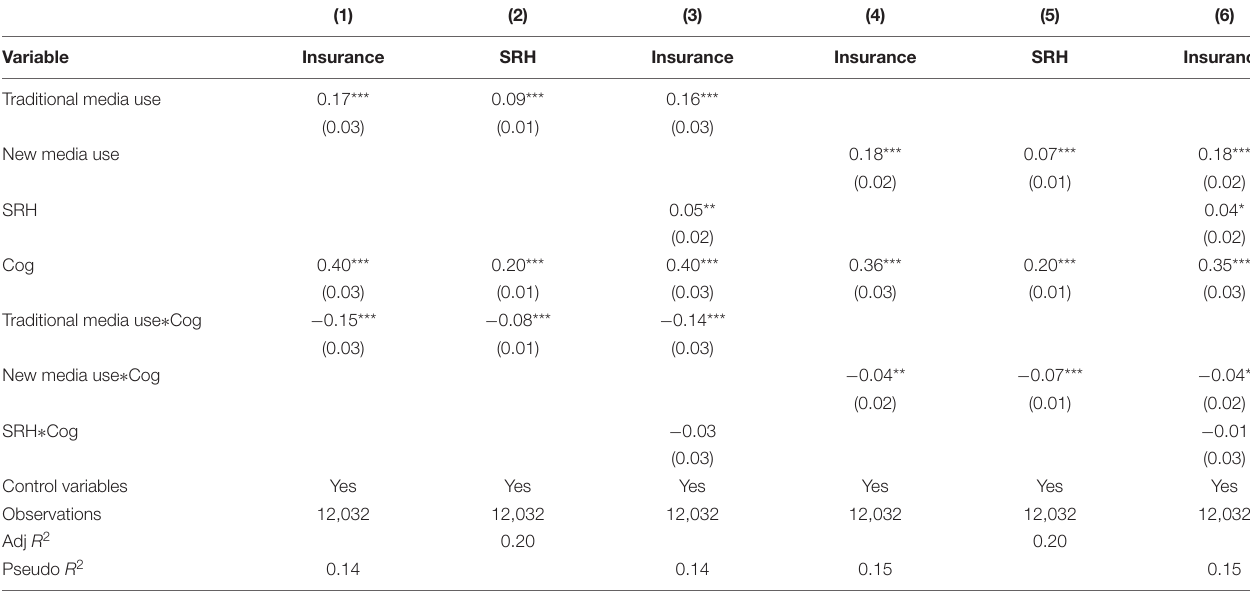
TABLE 6 | Regression results of moderated mediation model of media use on the purchase of private medical